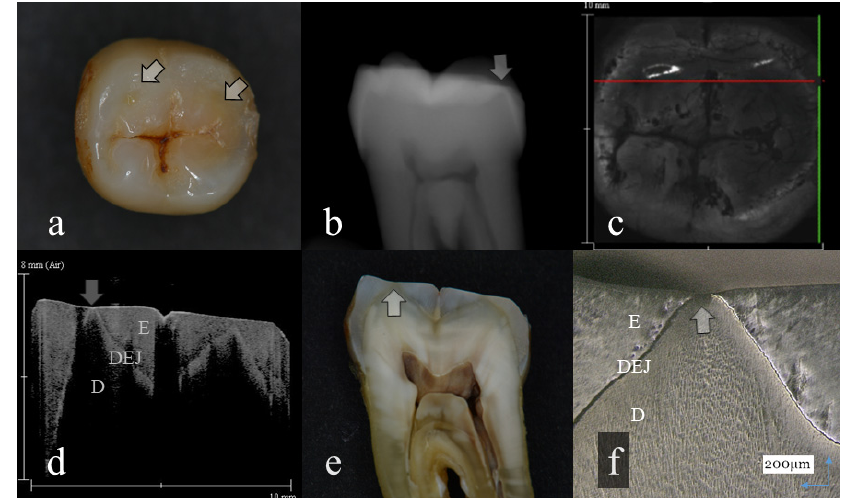
Figure 3. Tooth wear with slight dentin exposure (score 3): ( a ): Occlusal view. The buccal cusps and distal surface were flattened (arrows); ( b ): Digital intraoral radiography. Remaining enamel at the occlusal distal surface was thinned (arrow); ( c ): OCT en face intensity projection; ( d ): SS-OCT image. Occlusal enamel was worn showing the flattened surface. Loss of enamel reached to the DEJ with the slight involvement of dentin (arrow): ( e ): Histological view. Occlusal enamel wear reached to the DEJ depth (arrow); ( f ): CLSM image of histological view. Slight dentin exposure at the cusp was observed (arrow). The corresponding dynamic slicing 3D video in is Supplementary Materials: Video S3. The upper right is a cross sectional image. The image on lower right is an en face image.